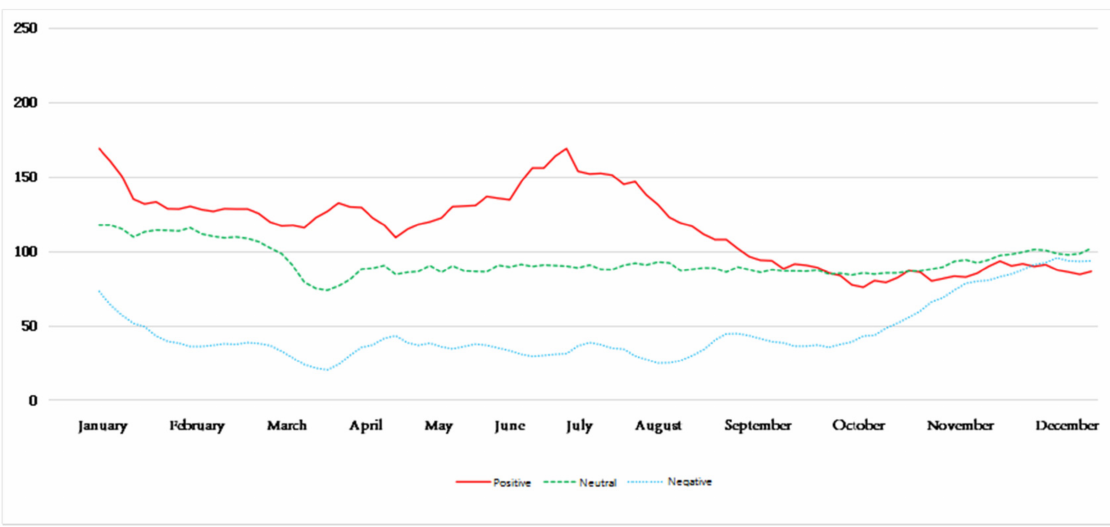
Figure 7. Five-day moving average of perceived emotions in spring.